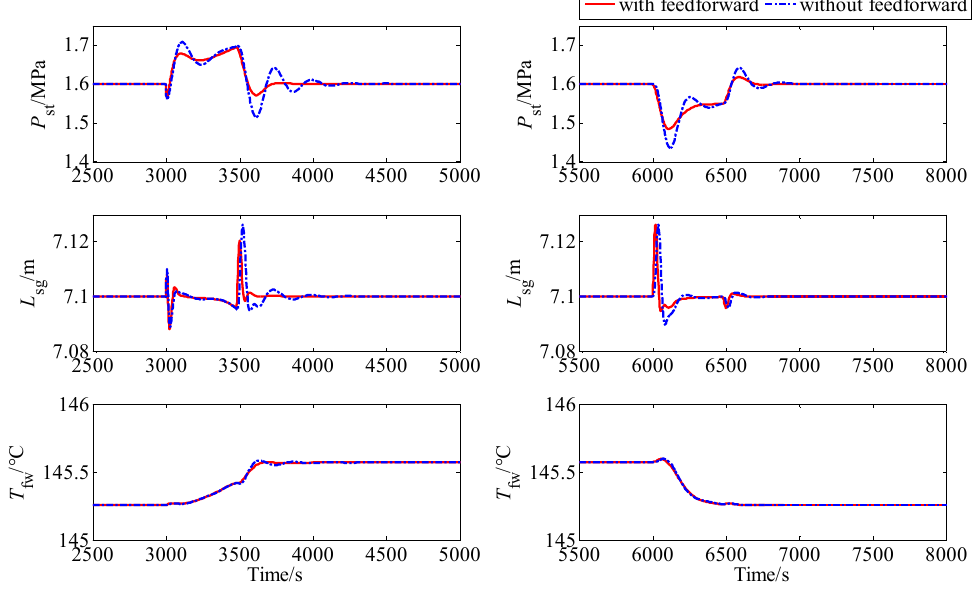
Figure 8. Responses of UTSG process variables in the case of load maneuvering, P st : live steam pressure, L sg : UTSG water-level, T fw : feedwater temperature.